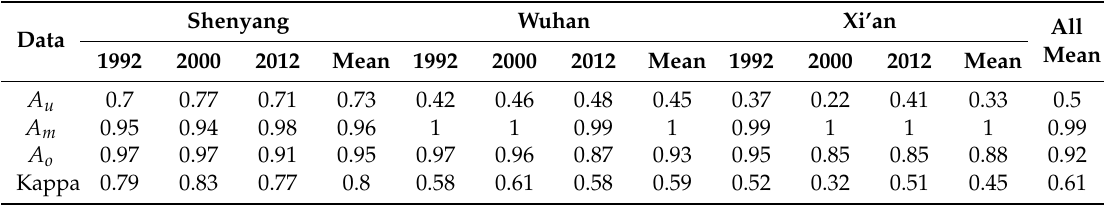
Table 10. Confusion matrix of the built-up area extraction method that uses ISODATA with DMSP/OLS. Shenyang Wuhan Xi’an Data